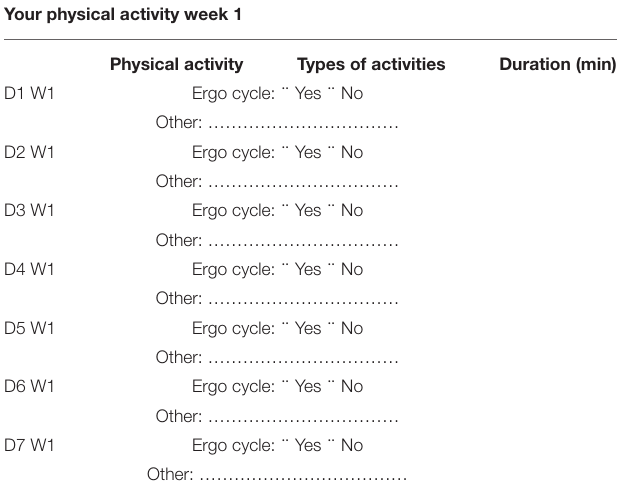
TABLE 2 | Frequency and type of Physical Activity week